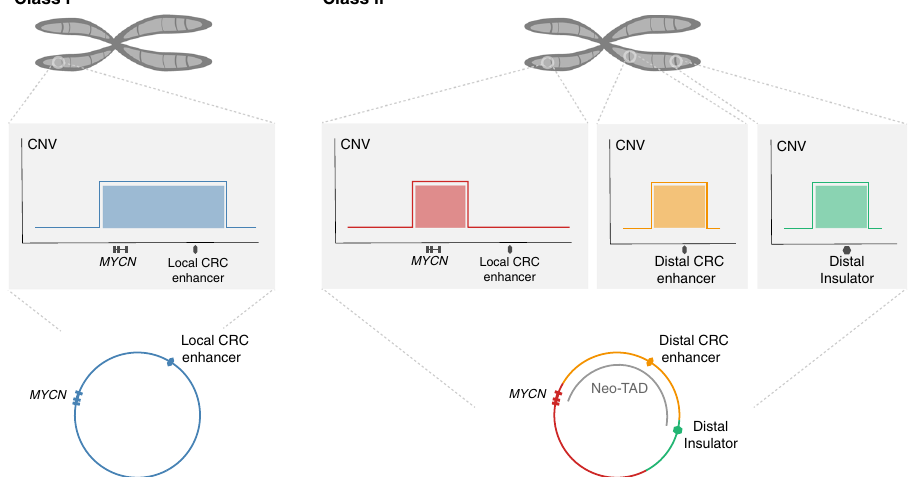
Fig. 7 Enhancer co-ampli fi cation determines MYCN amplicon patterns. In most cases, MYCN and its local gene-regulatory neighborhood including a CRC- driven super-enhancer is ampli fi ed (Class I). If the local neighborhood is not co-ampli fi ed, amplicons are more complex and recruit distal gene-regulatory elements (Class